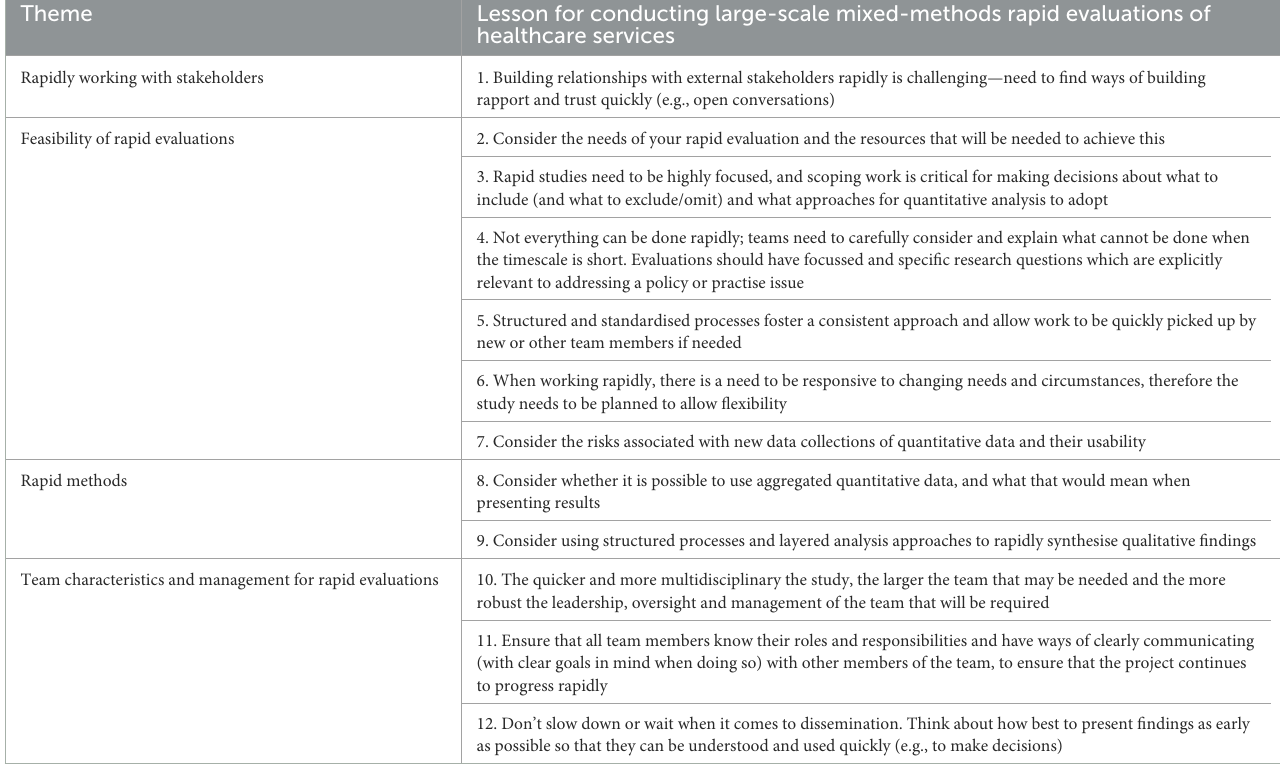
TABLE 3 Key lessons for conducting rapid evaluations of healthcare services.